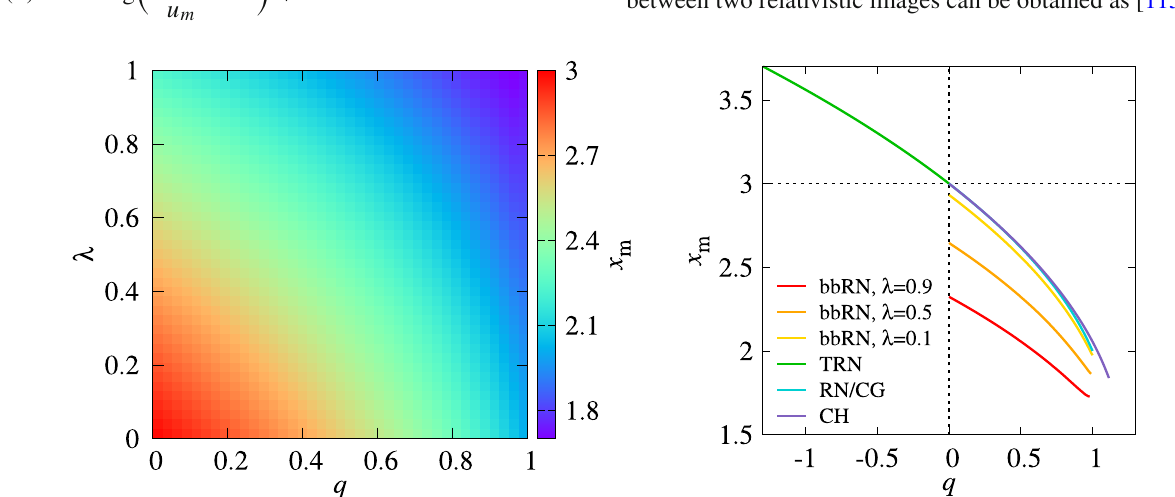
Fig. 6 Left panel: The dimensionless radius x m of the photon sphere for the black-bounce-Reissner–Nordström spacetime with respect to q and λ . Right panel: A comparison of x m among the black-bounce-